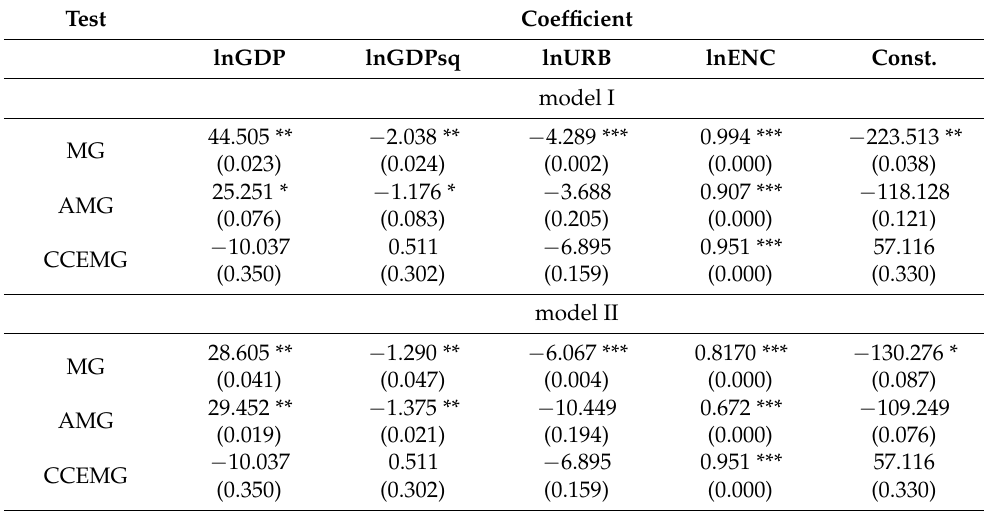
Table 8. Mean Group (MG), Augmented Mean Group (AMG), and Common Correlated Effects Mean Group (CCEMG) estimation